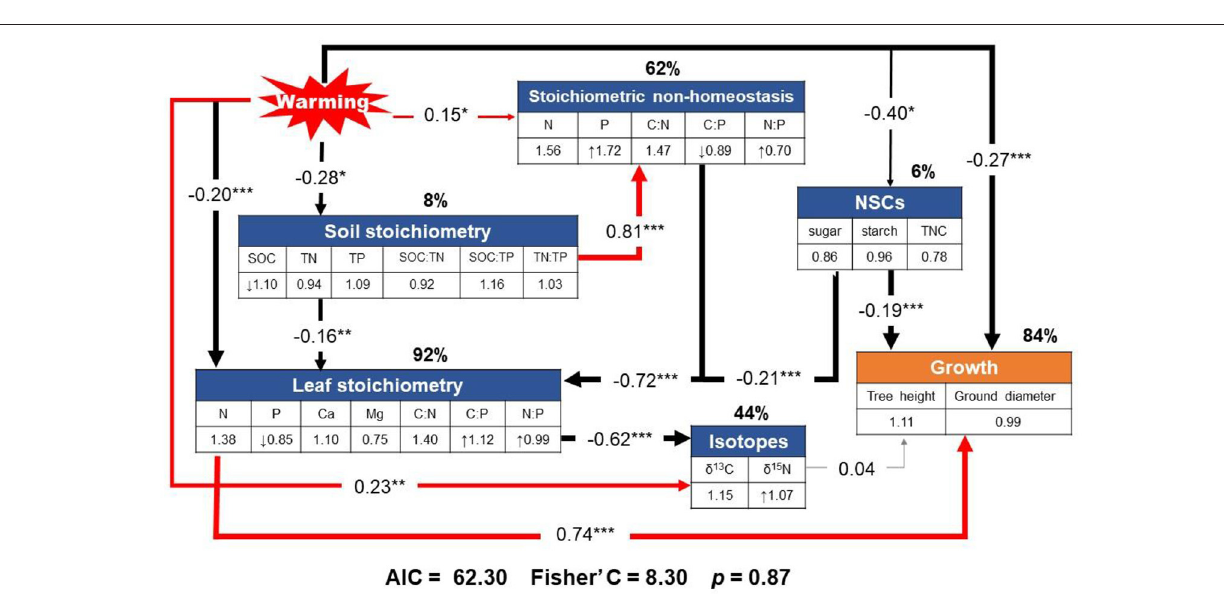
FIGURE 7 | Results from the final piecewise structural equation model illustrating the effects of changes in stoichiometric non-homeostasis due to warming on plant nutrients and the indirect effects of stoichiometric non-homeostasis on growth via pathways through leaf stoichiometry (i.e., nutrient-use efficiency), non-structural carbohydrates (NSCs), and stable isotopes (i.e., δ 15 N, as a proxy for N cycling). Path coefficients (correlation coefficients) along the arrows are standardized by the mean of each index. The symbols “ ↑ ” and “ ↓ ” indicate a significant increase and decrease, respectively, in response to warming. The number in the glen check denotes the slope of the linear model of each parameter with warming as a continuous predictor. Red and black arrows represent significant positive and negative relationships ( p < 0.05), respectively. Gray arrow represents insignificant correlation. *, **, and *** denote statistical significance at p < 0.05, p < 0.01, and p < 0.001, respectively. Percentages close to variables present the variance explained by the model ( R 2